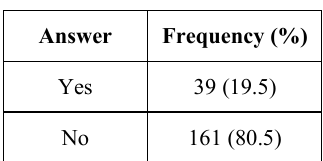
Table 3. The frequency table for answers in